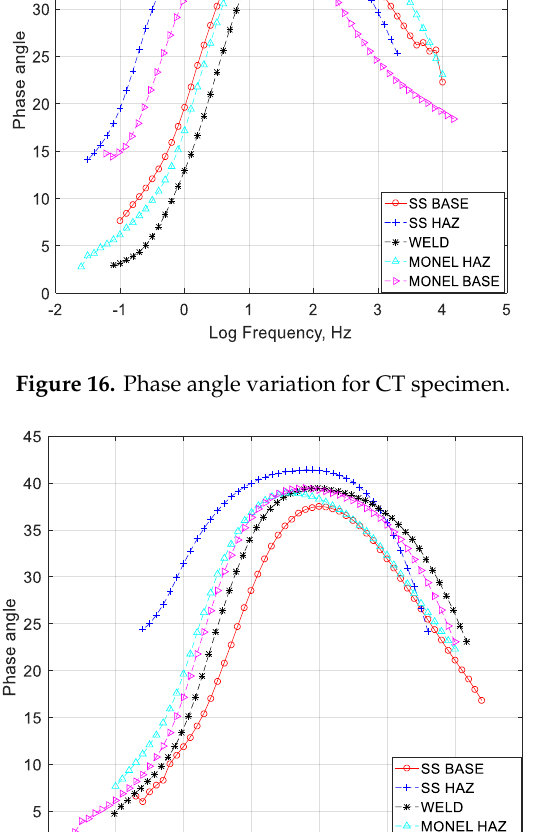
Figure 17. Phase angle variation for HT specimen. Table 3. Polarization parameters of Monel 400 and SS 316L for specimen’s CT and HT.